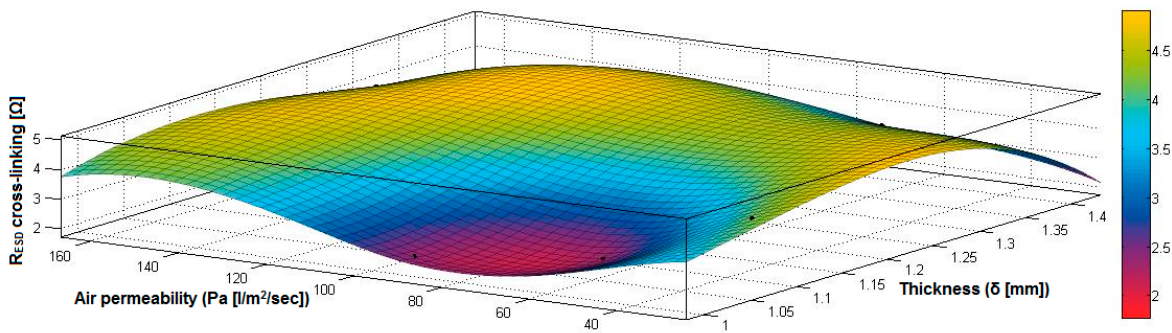
Figure 38. 3D representation R ESD after crosslinking = f(M, δ ) samples preliminarily treated in RF plasma O 2 using RF 2 generator and power 50 W.